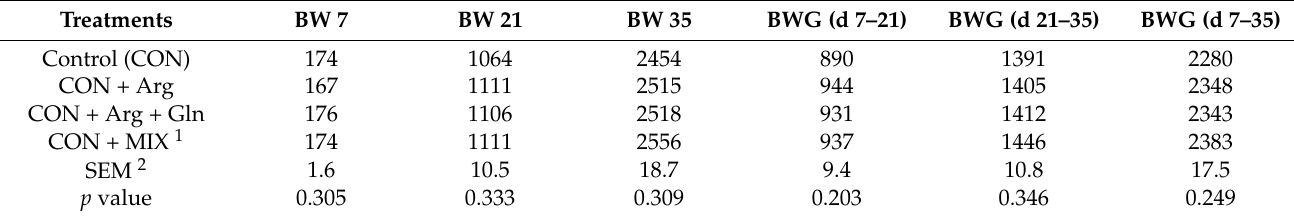
Table 3. Body weight (BW, g/bird) and body weight gain (BWG, g/bird) of broiler chickens fed experimental diets (experiment 1).